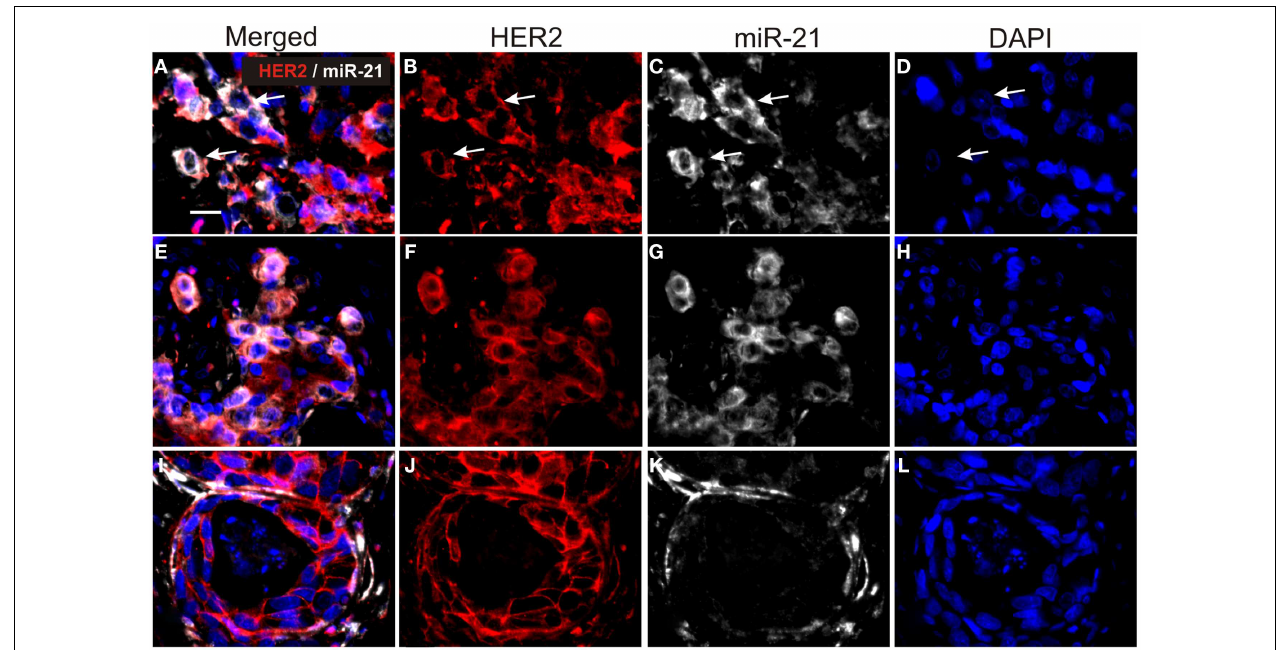
with DAPI (blue). miR-21 ISH signal is seen in HER2-positive cancer cells in cases (A–D) and (E–H) [examples are indicated by arrows in (A–D) ], whereas HER2-positive cancer cells in case (I–L) are miR-21-negative.The examples are from tumors in the reference group and are representative for the three tumors. Bars: 20 µ m.